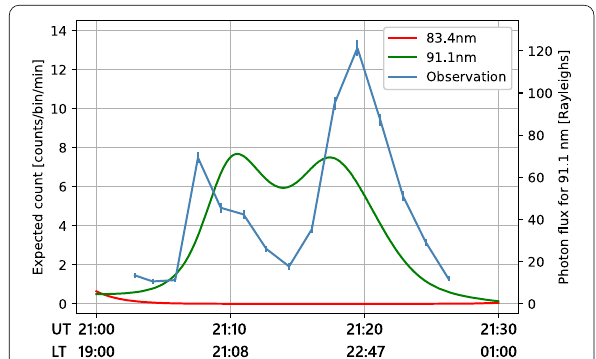
Fig. 4 Simulated EUV intensity for EUVI-B for 21:00–21:30 UT on December 26, 2012. The red line indicates the time profile for 83.4 nm EUV and the green line indicates the time profile for 91.1 nm EUV. The blue line shows the mean count observed by EUVI-B which was shown in Fig. 3 for comparison. The scale for converting the expected count into the photon flux in Rayleighs is also shown on the righthand side of this